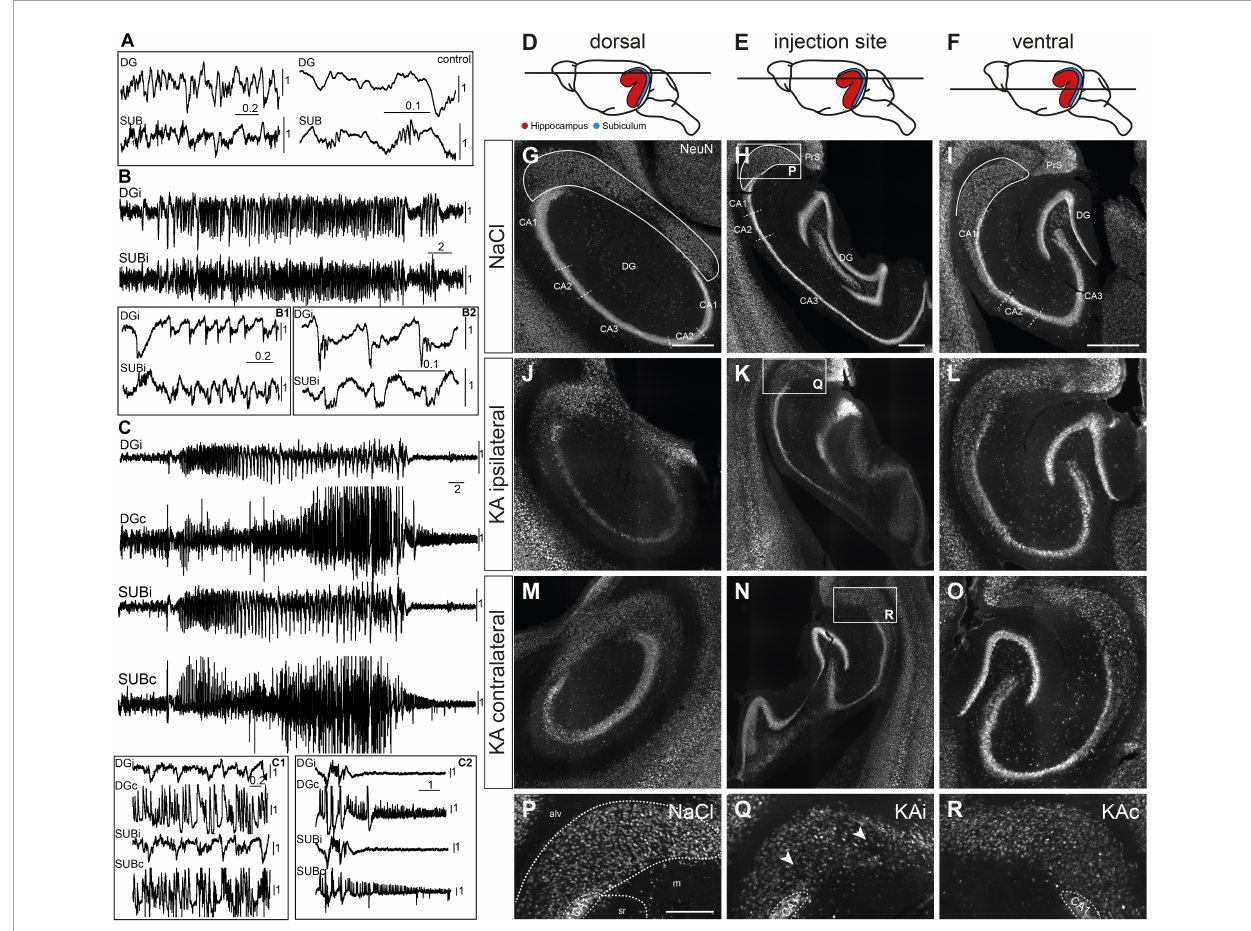
FIGURE1 Epileptiform activity and neuronal loss in the subiculum. (A) Local field potential recording of a control mouse during awake immobility shows irregular activity in the dentate gyrus (DG) and subiculum (SUB) with sharp-wave-ripple complexes in the subiculum (enlarged traces at right side). (B) Kainate (KA)-injected mouse. Subclinical epileptic activity (during immobility, without behavioral correlate) involved the ipsilateral DG (DGi) and subiculum (SUBi). Epileptiform populations spikes are enlarged in panels (B1,B2) , panel (B2) also shows high frequency oscillations superimposed on population spikes in the DG and the subiculum. (C) Generalized convulsive seizure recorded in the DG and subiculum of both hemispheres. (C1) Cutout depicting large amplitudes on the contralateral side. Post-ictal depression (C2) starts earlier on the ipsilateral than on the contralateral side. Scale bars in panels (A–C) : horizontal–time in s, vertical–voltage in mV. Individually scaling of channels for visibility of characteristic patterns. (D–F) Schematic drawings represent the three investigated positions (D) dorsal, (E) injection site, (F) ventral along the dorso-ventral (DV) axis. Note that the subiculum (blue) is partly hidden behind the hippocampus (red) in the side view of the mouse brain. (G–R) NeuN immunostaining. Horizontal sections of the hippocampal formation from NaCl-injected control mice (G–I) were compared to 21 days after KA (J–R) . The position of the subiculum is encircled in panels (G–I) . (J) Ipsilateral side, dorsal position. At 21 days after KA the characteristic extensive cell loss in the CA regions confirms successful KA injection. Cell density in the subiculum is reduced. (K) Ipsilateral side, level of the injection site. Cell loss in the CA region and subiculum together with dispersion of the granule cell layer is visible. (L) Ipsilateral side, ventral position. The hippocampus and subiculum appear comparable to control. (M–O) Pattern of NeuN + cells in the contralateral hippocampus and subiculum is comparable to controls at all DV levels. (P–R) Cutouts [white box in panels (H,K,N) ]: subiculum at the level of the injection site. The borders of the subicular pyramidal cell layer toward the alveus (alv) and the molecular layer (m) are delineated as dashed lines in panel (P) according the brain atlas (Franklin and Paxinos, 2008). (P) Dense arrangement of neurons in the subiculum after NaCl injection. (Q) Decreased neuronal density in the ipsilateral subiculum after KA injection. Arrows mark positions of reduced cell density in the proximal subiculum close to CA1 and in the distal subiculum close to the border to the presubiculum. (R) The contralateral subiculum after KA injection is comparable to control, but NeuN staining is weaker in some mice. Scale bars: (G–O) 500 µ m, (P–R) 250 µ m. alv, alveus; CA, cornu ammonis ; DG, dentate gyrus; m, molecular layer; PrS, presubiculum; sr, stratum radiatum